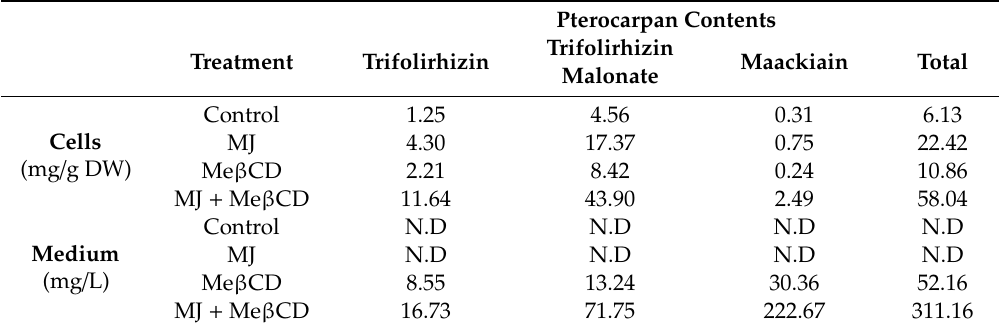
Table 2. Enhanced production of pterocarpans in the cells and medium of S. flavescens cell cultures, elicited by MJ, Me β CD, and MJ + Me β